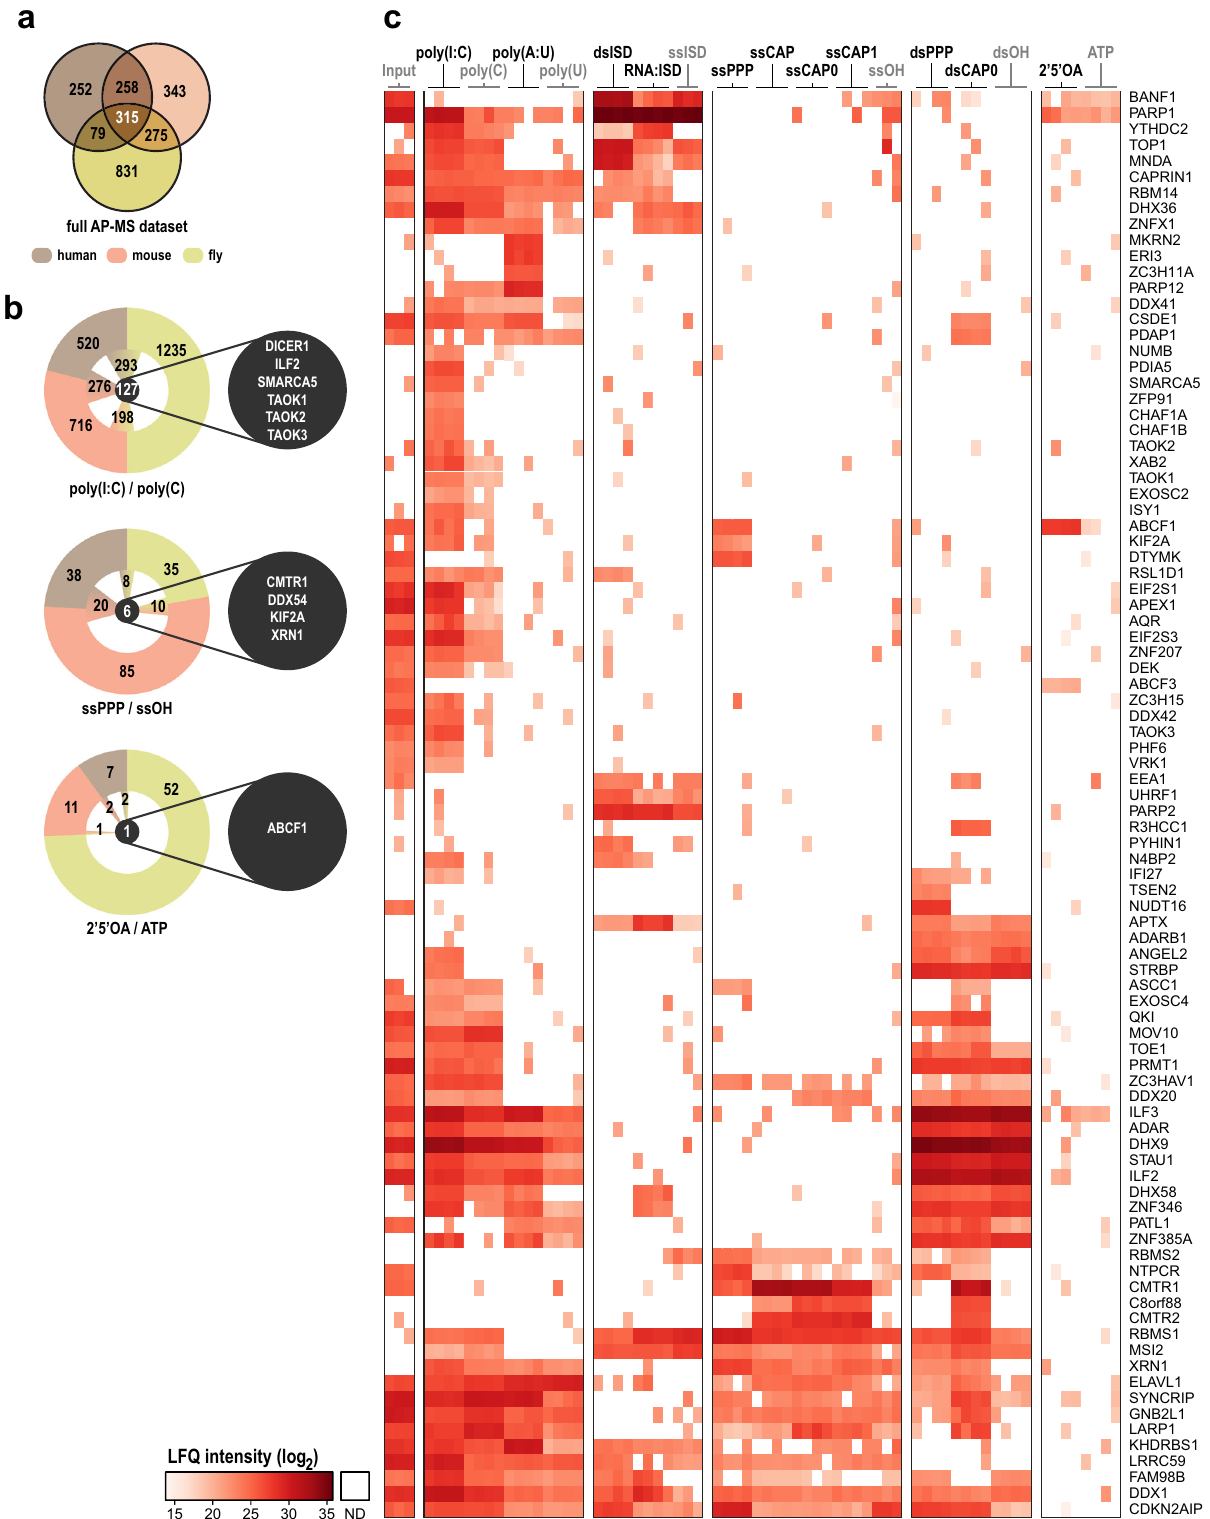
Fig. 2 Conservation of NA binding across species and candidates selected for functional experiments. a Venn diagram of all NA-enriched proteins identi fi ed in all AP-MS screens. b Signi fi cantly enriched proteins bound to poly(I:C) (top), ssPPP (middle), and 2 ’ 5 ’ OA (bottom), including the overlap between species (brown: human, red: mouse, and green: fl y). Proteins enriched in all three species are provided in the callout circle. c Heatmap showing log 2 LFQ intensities of 90 candidates individually selected for their speci fi city of enrichment for individual NAs, conserved enrichment between species, and regulation of protein abundance after virus infection, as well as protein abundance in the input lysate (Input). ND not detected. Candidate clustering is based on Euclidian distance and Ward as agglomeration